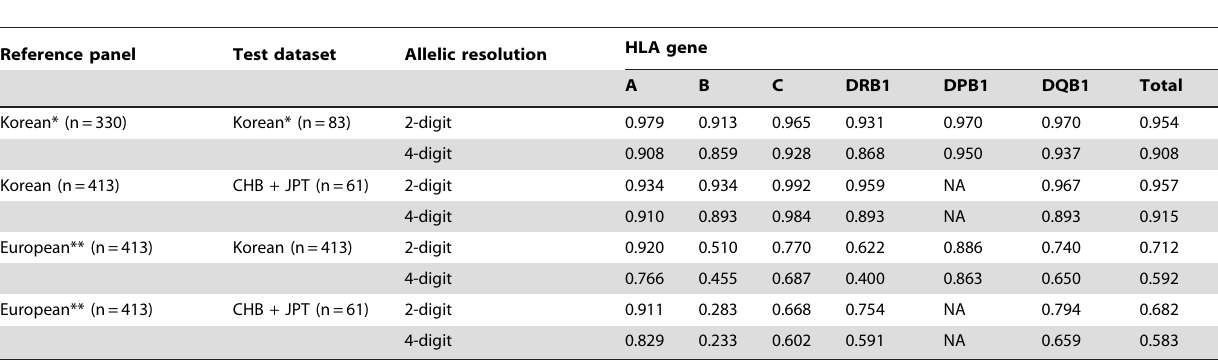
Table 2. Concordance rates between imputed and genotyped alleles.